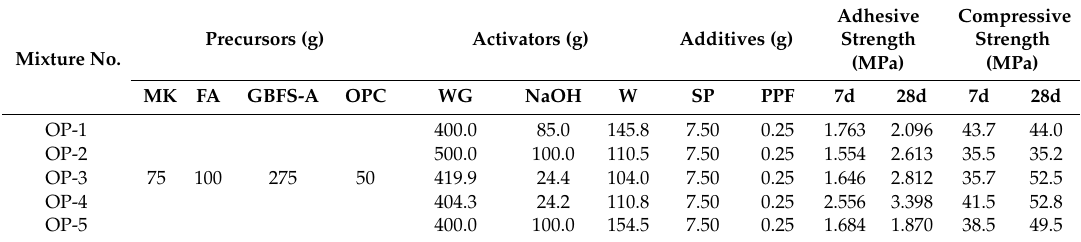
Table 3. Adhesive strength of the optimized geopolymer coatings mixtures.